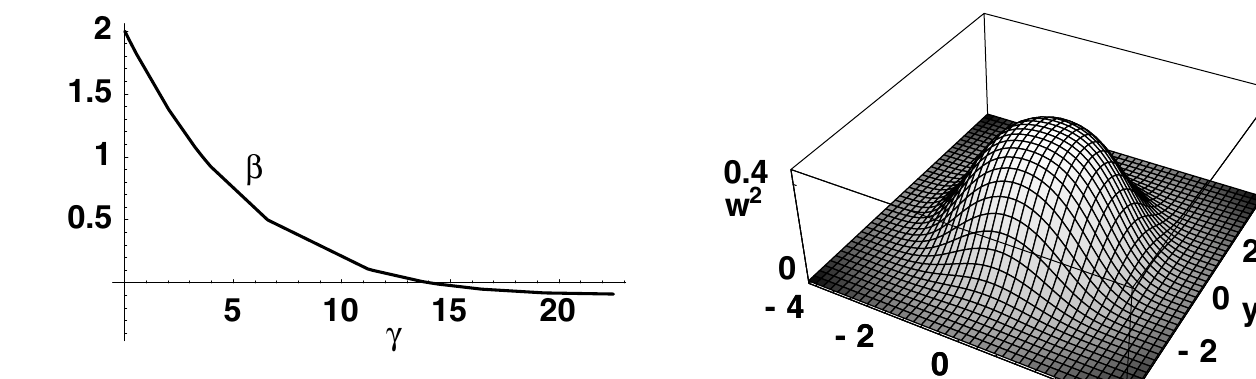
FIG. 1. The energy (cid:6) as a function of the space-charge strength (cid:7) . Actually these quantities are dimensionless, meas- ured in units of the energy (cid:10) 2 = 4 m- 2 (cid:21) 37 : 5 eV .